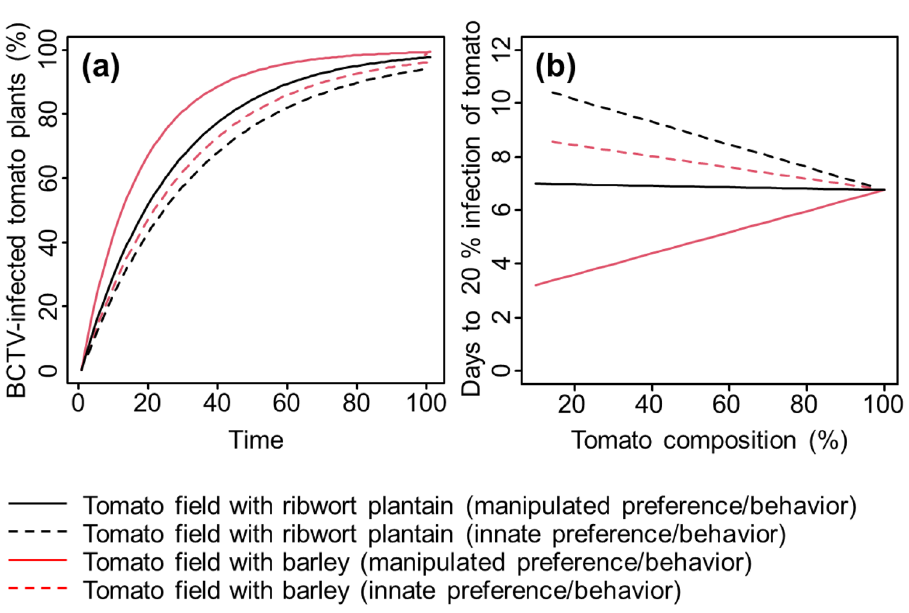
Figure 5. BCTV manipulation effects on ( a ) the percentage of BCTV-infected tomato plants and ( b ) the time to 20% infection of tomato plants across various tomato compositions were examined in tomato fields with ribwort plantain or barley as a trap crop. The cases with manipulated preference and innate (without manipulated) preference are shown in solid and dashed lines, respectively. Black lines represent tomato fields with ribwort plantain as a trap crop and red lines represent tomato fields with barley as a trap